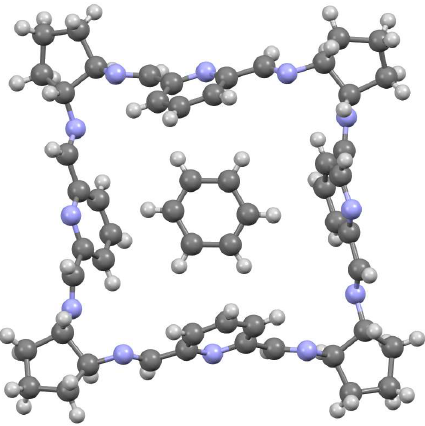
Figure 22. [4 + 4] macrocycles derived from DFP.